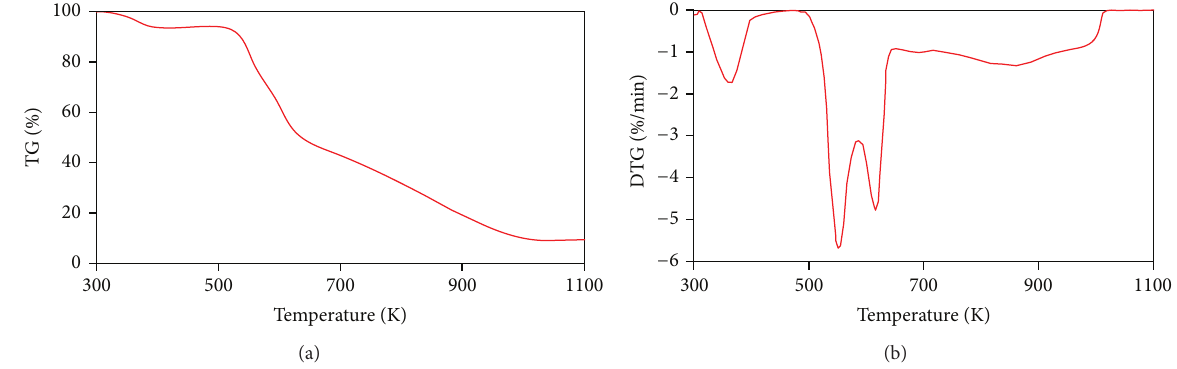
Figure 1: (a) Thermogravimetric (TG) analysis of coconut shells. (b) Differential thermogravimetric (DTG) analysis of coconut shells.